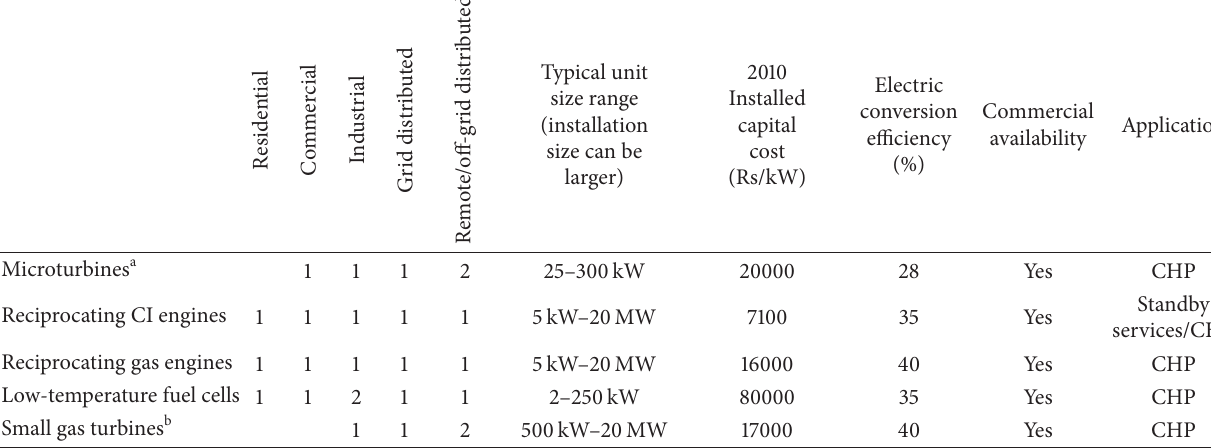
Table 3: Technologies: markets and performance.